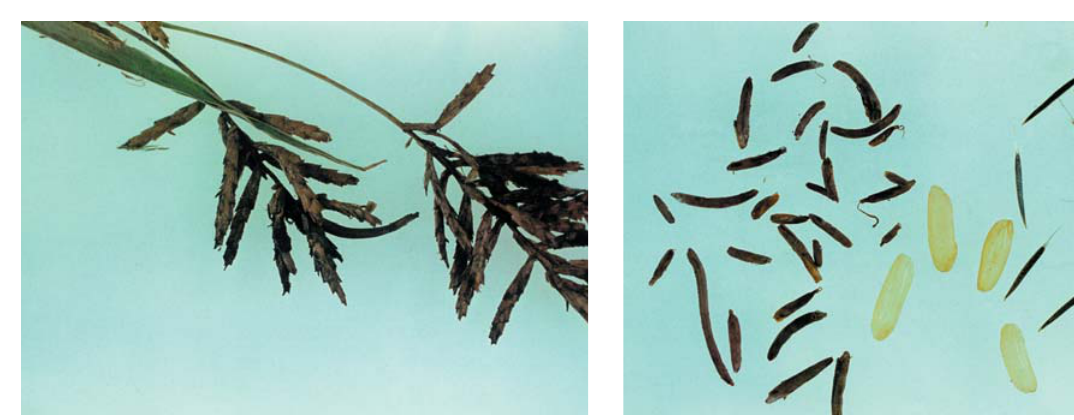
FIG. 7 The small, black, rod-like Claviceps cyperi sclerotia in dried maize silage (compare with Fig. 10)